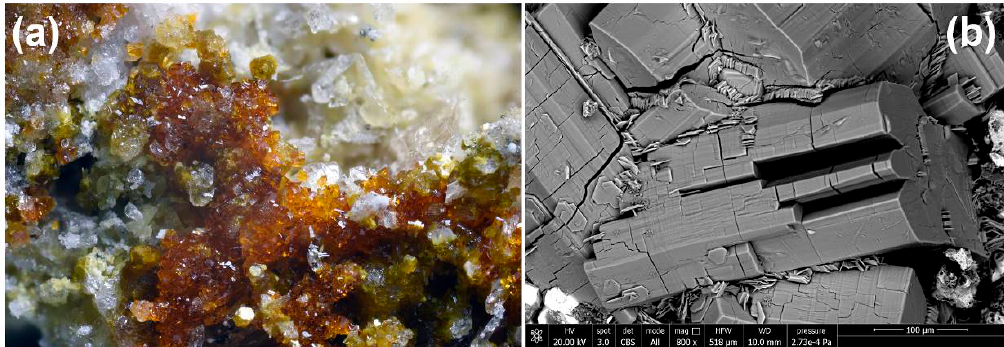
Figure 10. Fibroferrite from the Fornovolasco mine, as spongy fibrous aggregates. Field of view: 4 cm.